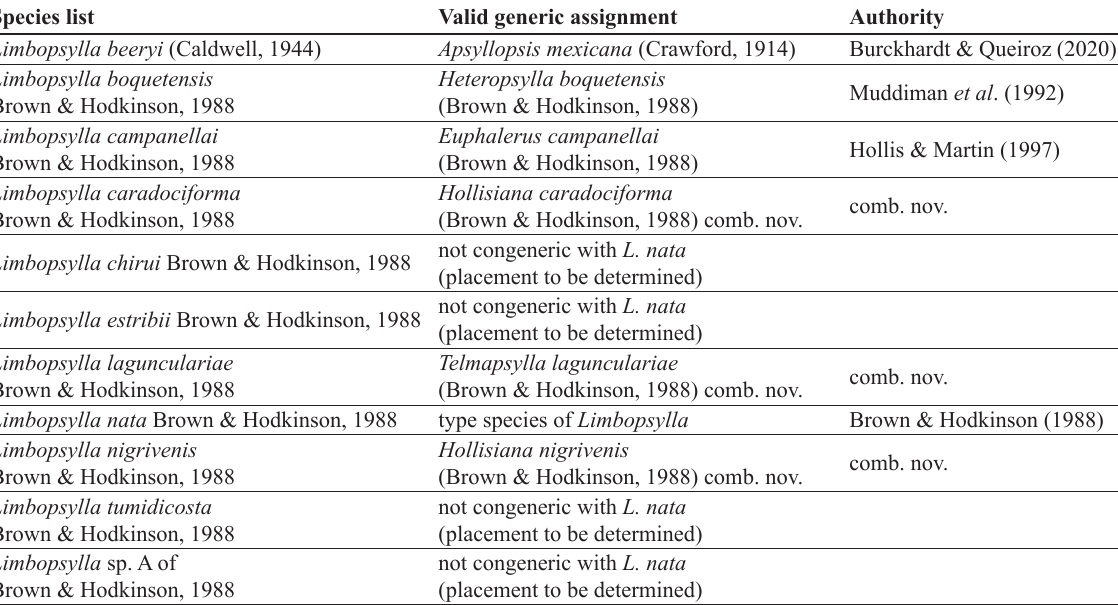
Table 1. Species in Psyllidae originally assigned to Limbopsylla Brown & Hodkinson, 1988 and their current generic